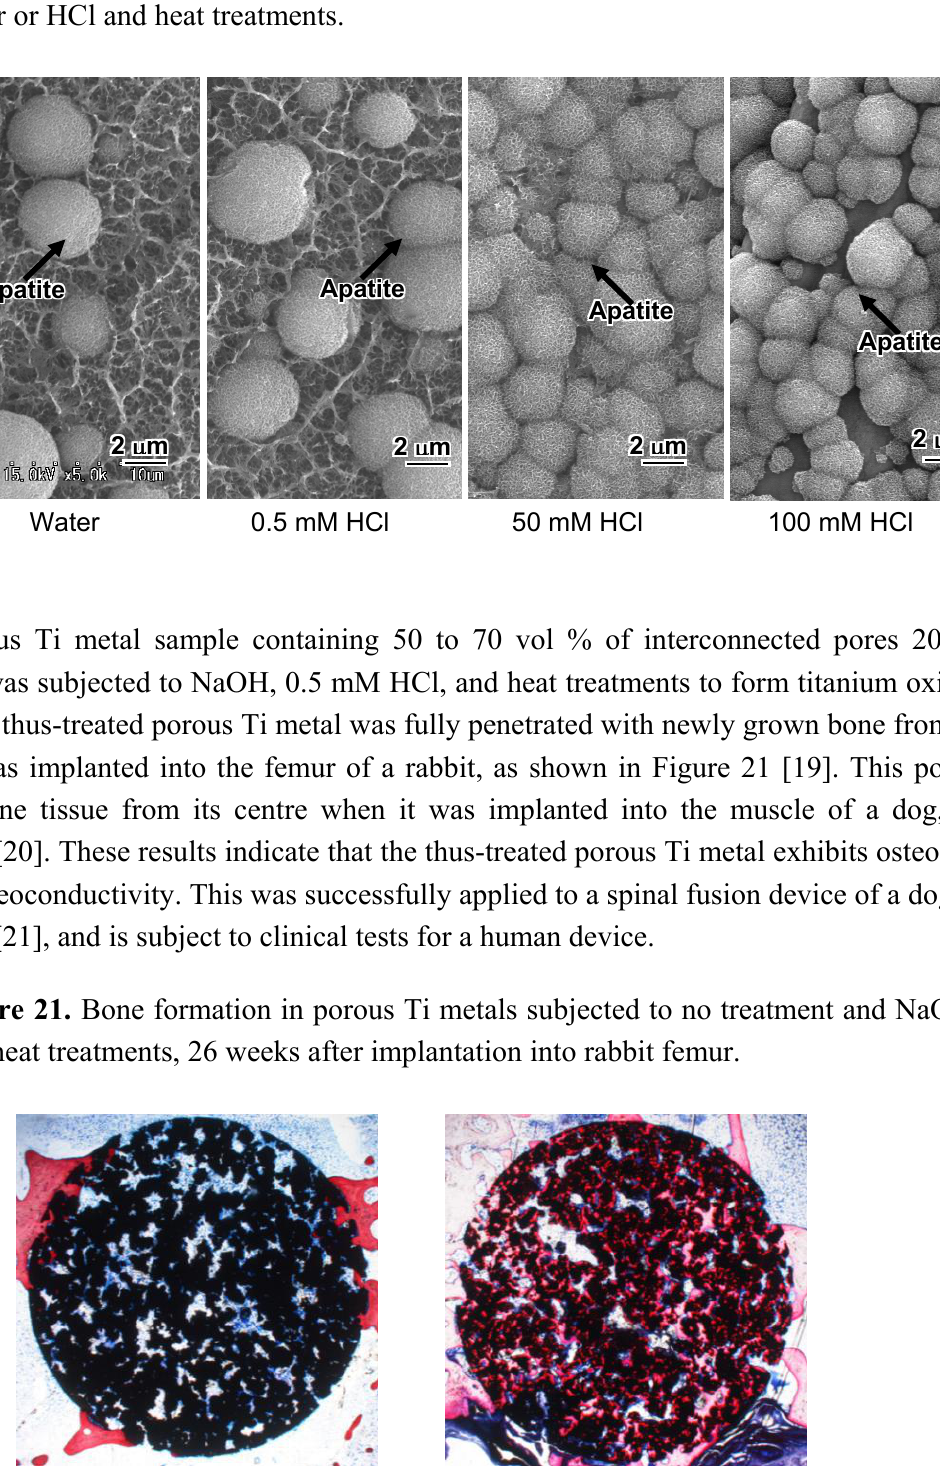
Figure 20. SEM photographs of surfaces of Ti metals soaked in SBF for 1 d, after NaOH, water or HCl and heat treatments.